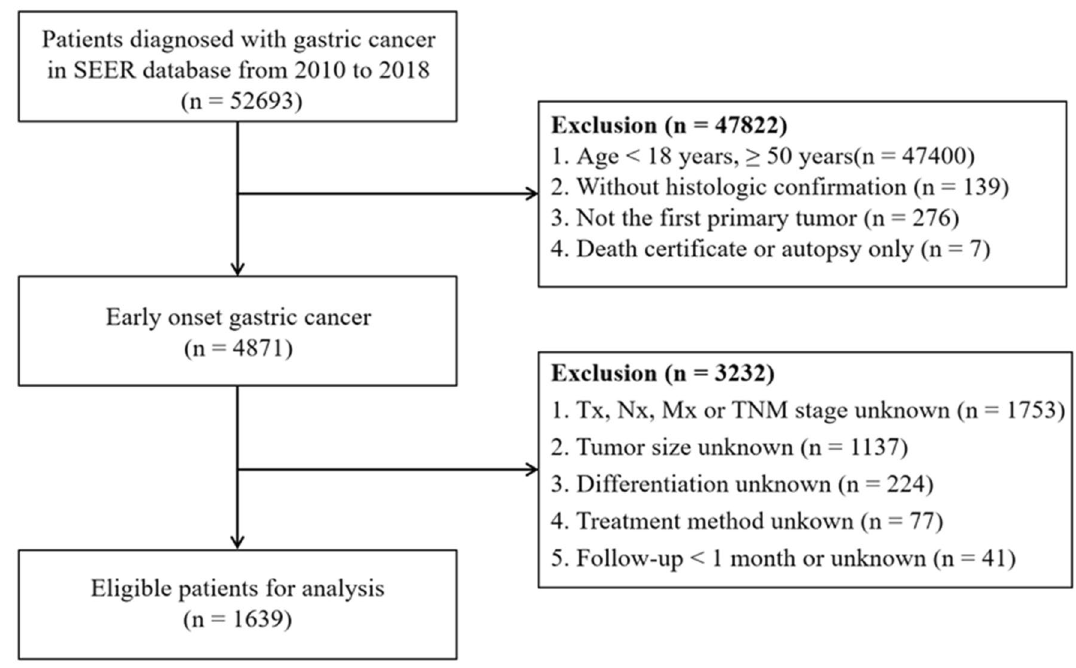
Figure 1. Flow diagram of eligible young patients diagnosed with gastric